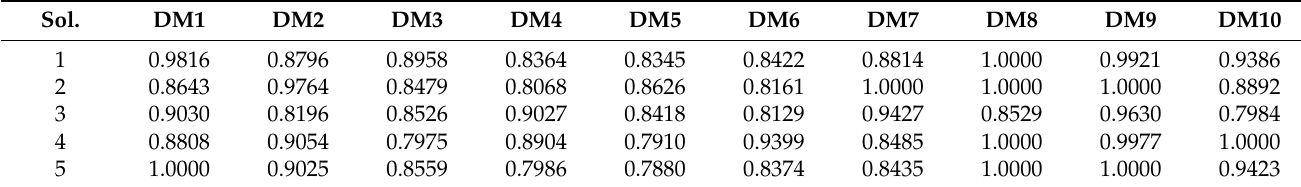
Table A6. Values of σ i ( Z Gki , B i , λ i ) for the solutions in Table